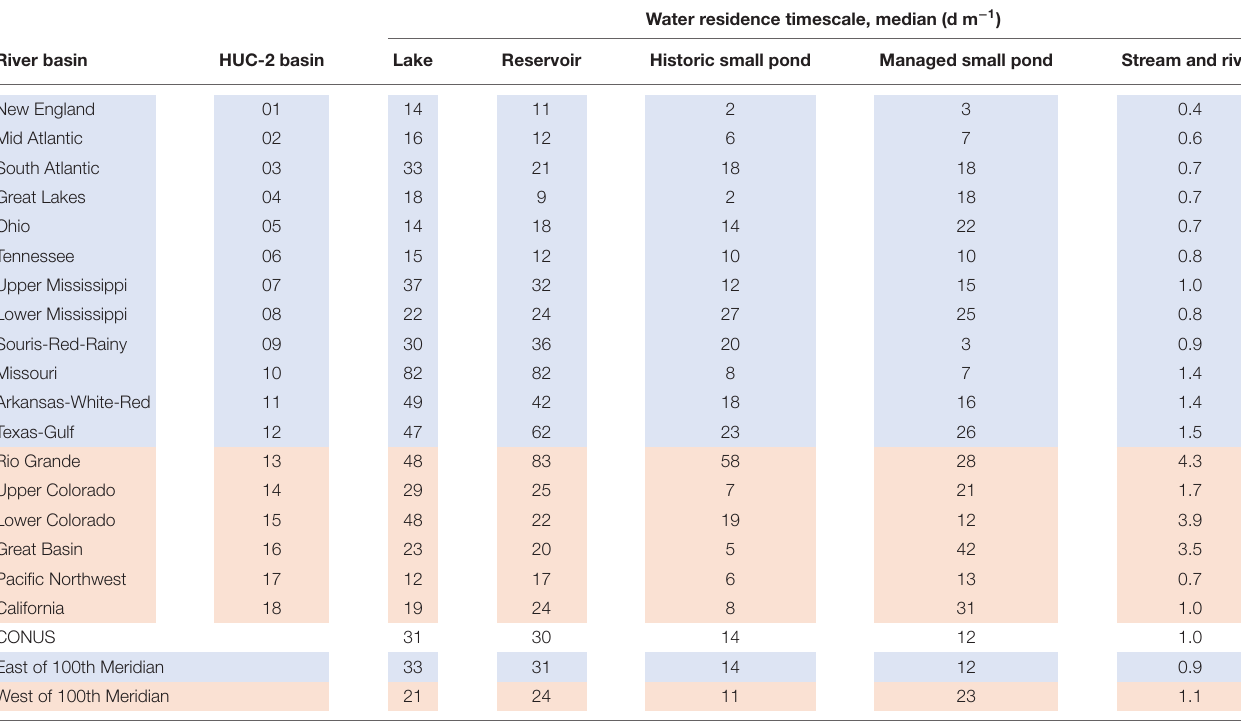
TABLE 2 | Summary table of the median water residence timescale for individual lotic and lentic features of the CONUS, eastern and western regions, and major river